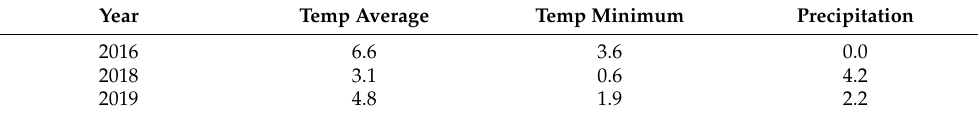
Table 10. Temperature (in °C) and precipitation (in mm) data for the month of September (end of accumulation time) in the years 2016, 2018 and 2019 on the Tyndall Glacier (Temp–Temperature). Temp